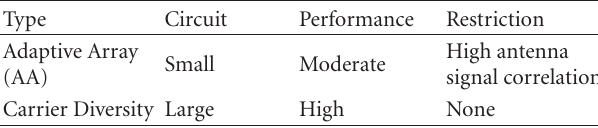
Table 1: Features of two diversity